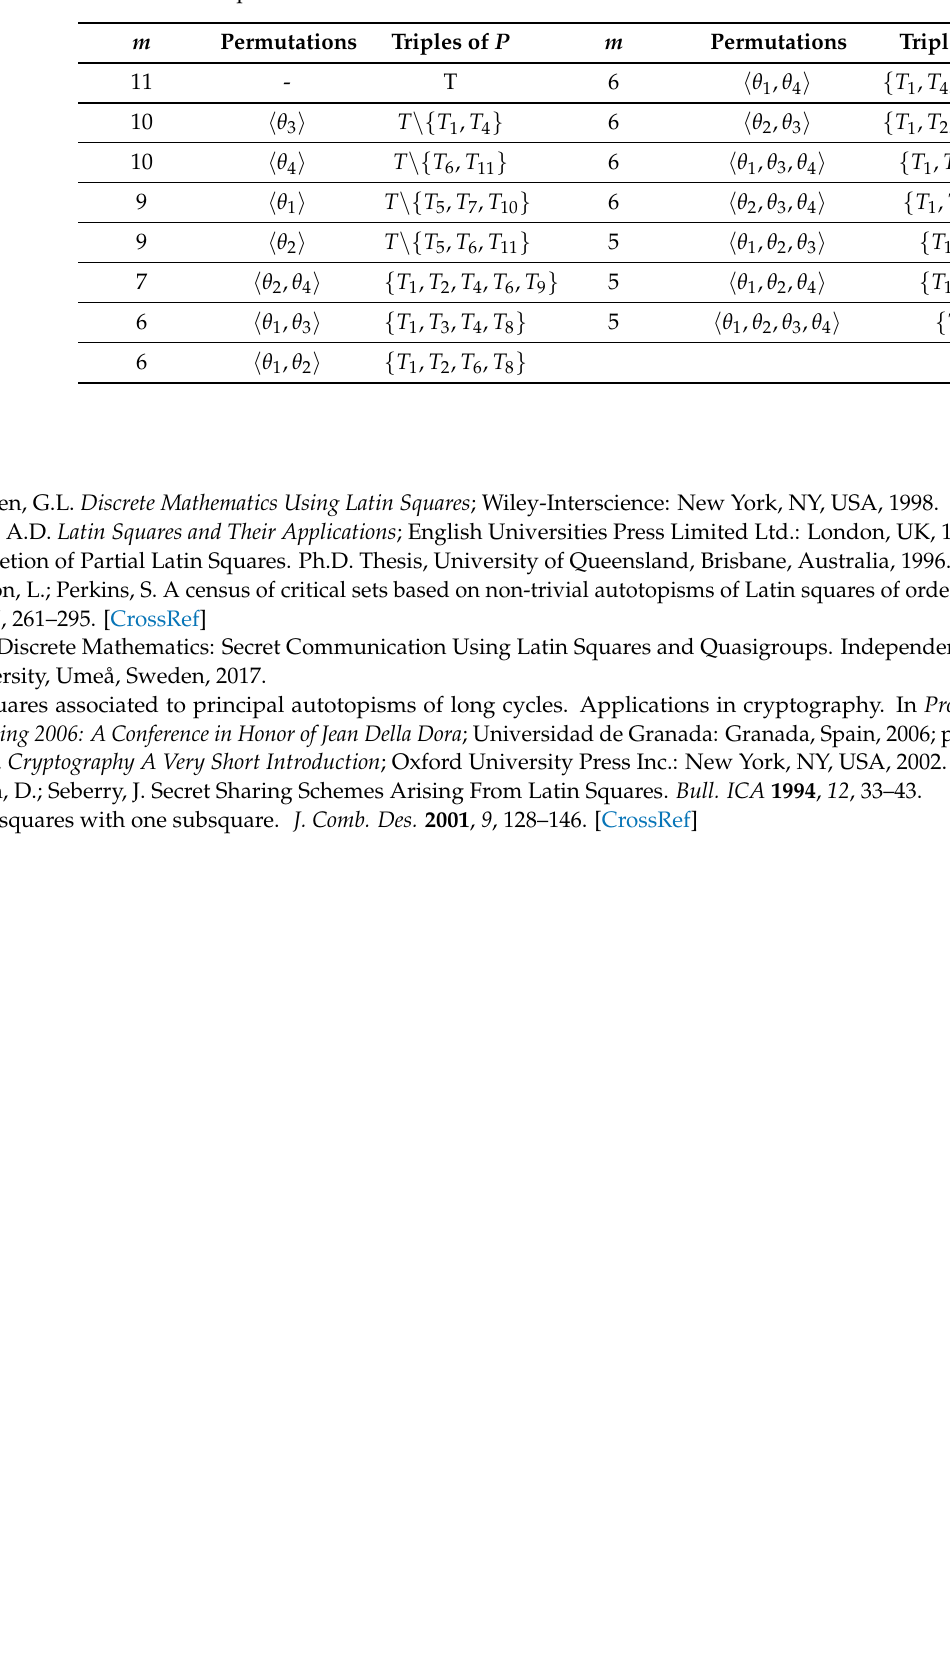
Table A2. Examples of access levels as outlined in Table